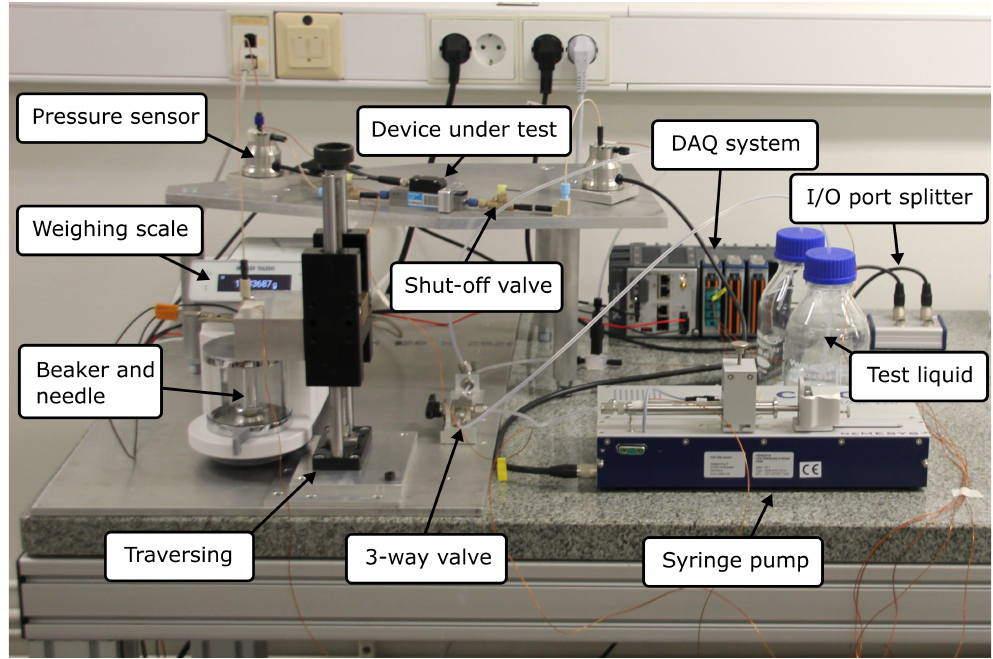
Figure 2. Photo of a typical measurement setup (Nanoflow test facility) for the calibration of a flow meter as